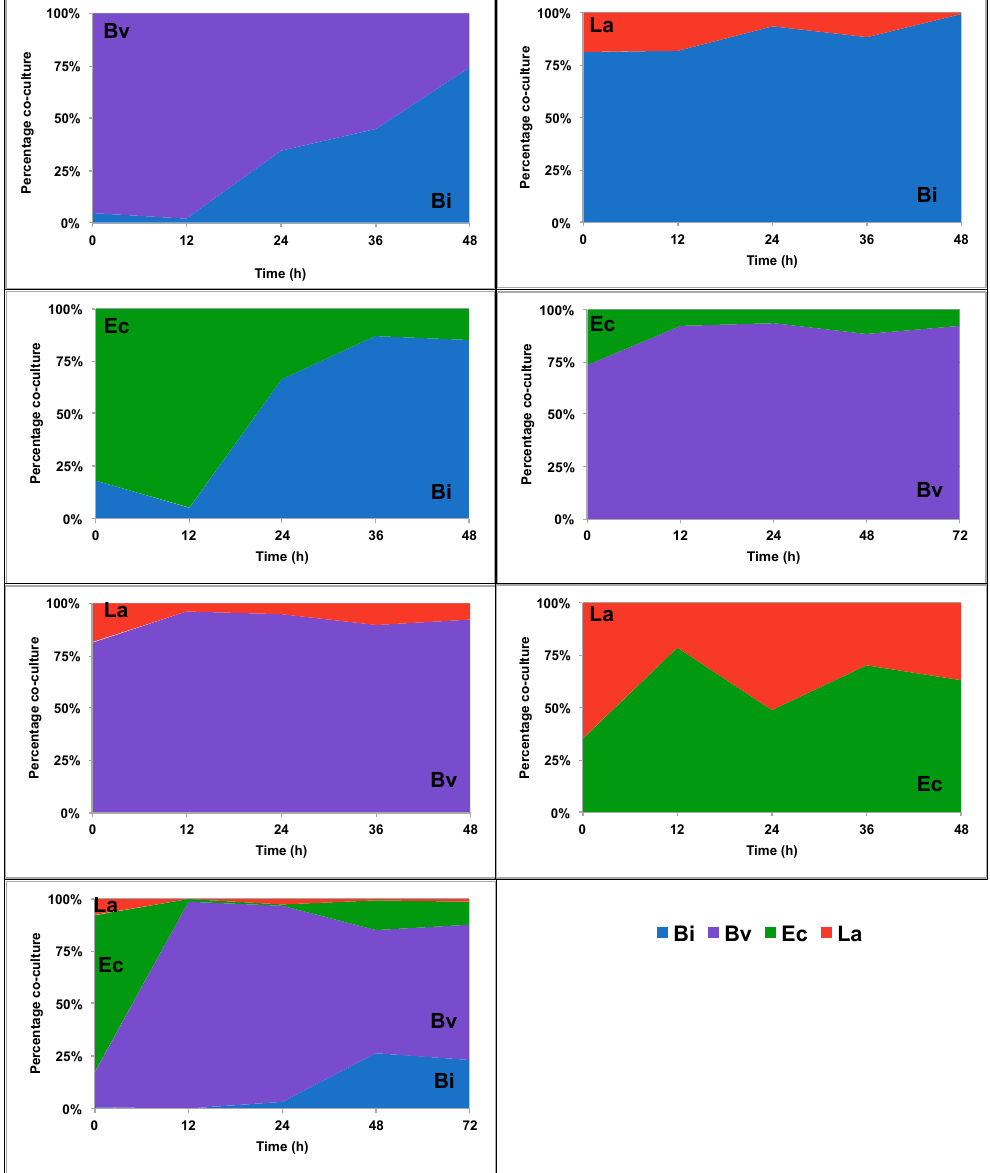
Figure 2. Bacterial abundance in co-culture experiments using 2 ′ -fucosyllactose (2FL). Co-cultures of Bi ( Bi. infantis ), Ba ( Ba. vulgatus ), Ec ( E. coli ) and La ( L. acidophilus ) were grown as shown in the legend. Cell copy numbers were determined every 12 h. Percentages represent the proportion of the cell copies for each bacterium in each combination.